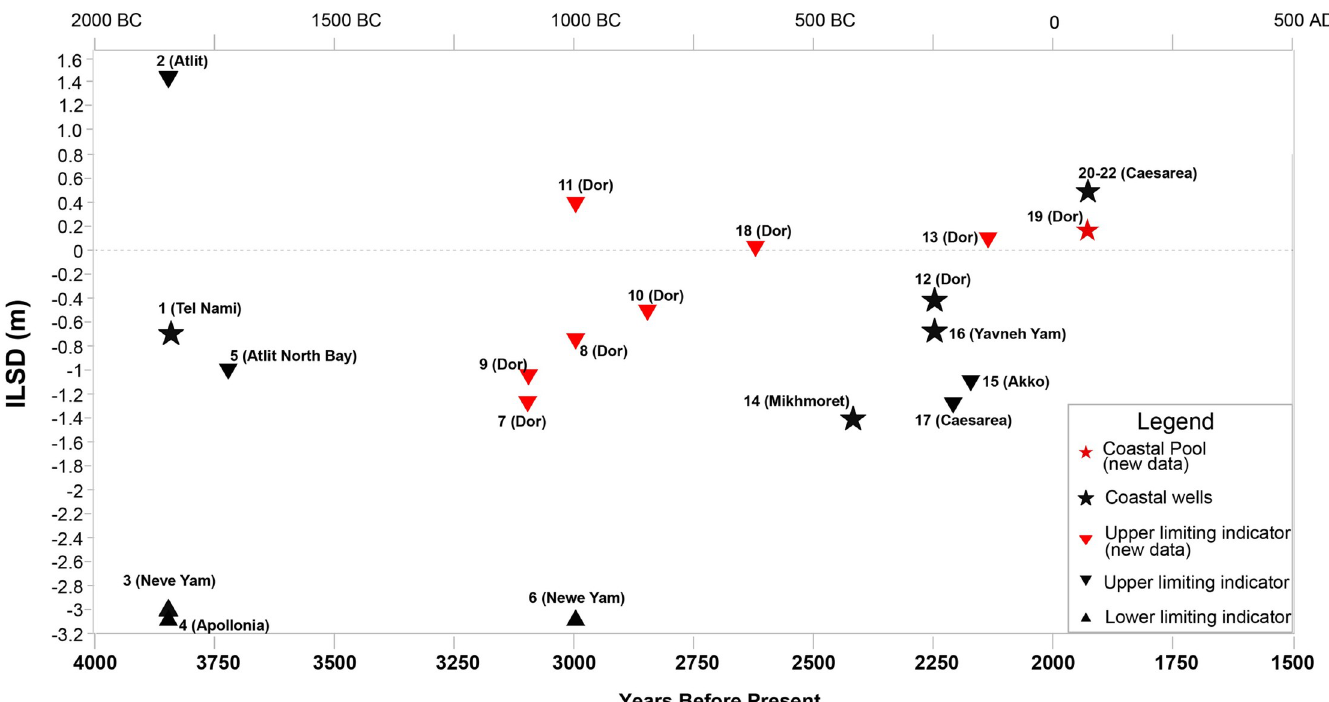
Fig 4. Base elevation and timeline of the archaeological constructions used in the current research for evaluating relative sea level.